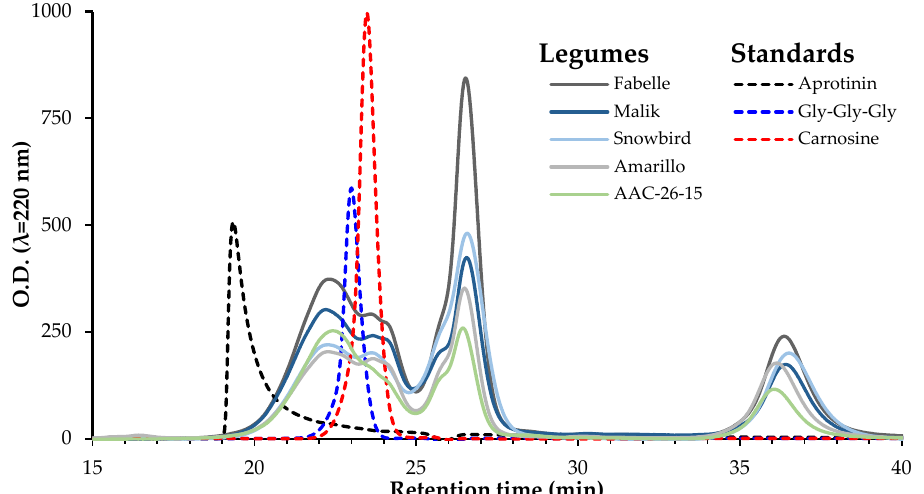
Figure 5. Molecular weight distribution of peptides in the 3 kDa permeate of legume digestates as assessed by size exclusion HPLC.